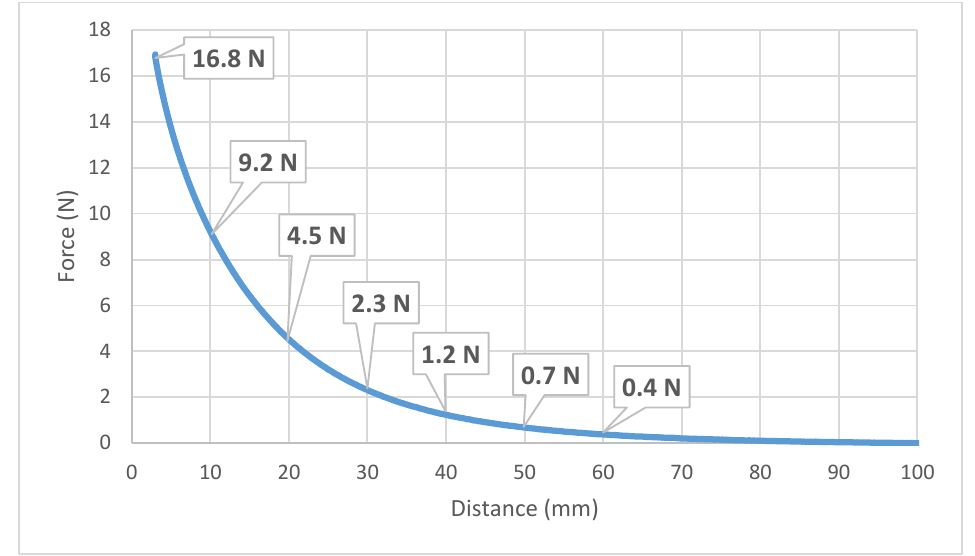
Figure 13. Experimental setup attaching the rod magnet to the upper leg with the north pole oriented toward the upper leg and with a central axial alignment.